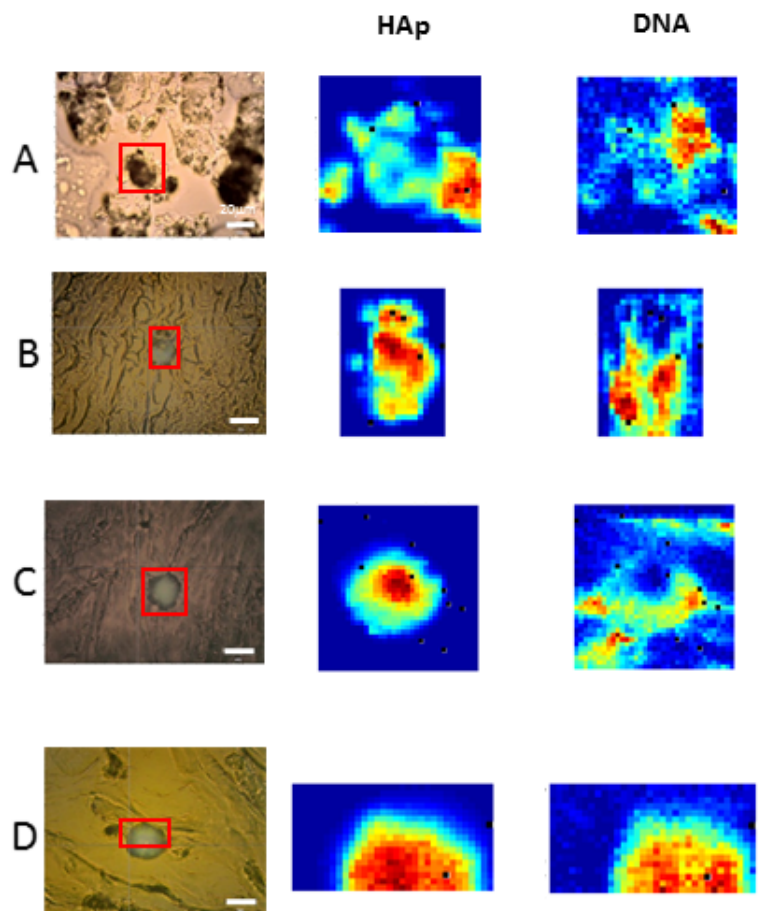
Figure 3. Raman spectral images of different breast cancer tissue sections showed the presence of DNA in HAp calcifications. First column: Bright field image of the breast tissue section imaged, with a HAp calcification highlighted in the region of interest (red box). Raman images were obtained from this area. Using the MCR algorithm, several molecular components were deconvolved from the spectra. The abundance maps of HAp and DNA molecular components are plotted in the second and third columns. Tissues ( A – D ) correspond to tissues 20, 22, 1 and 9 in Table 1.